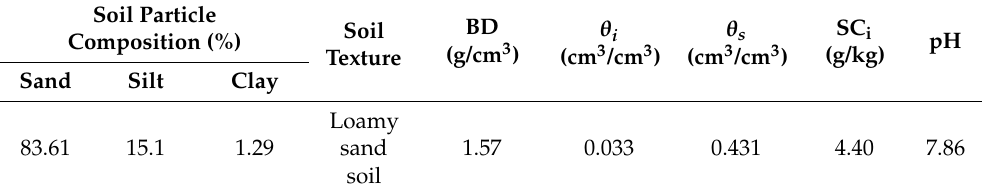
Table 1. The basic physical properties of